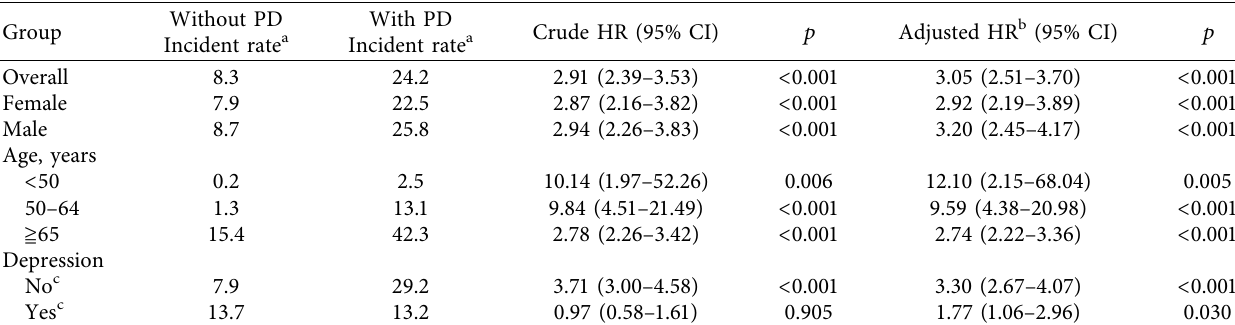
Table 3: Incident rate and hazard ratio for dementia with PD.